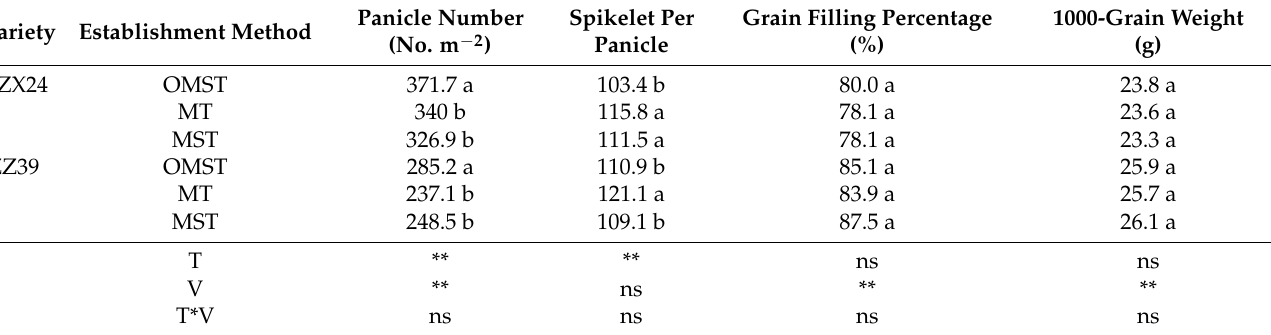
Table 1. The grain yield components under different rice establishment methods in 2021.